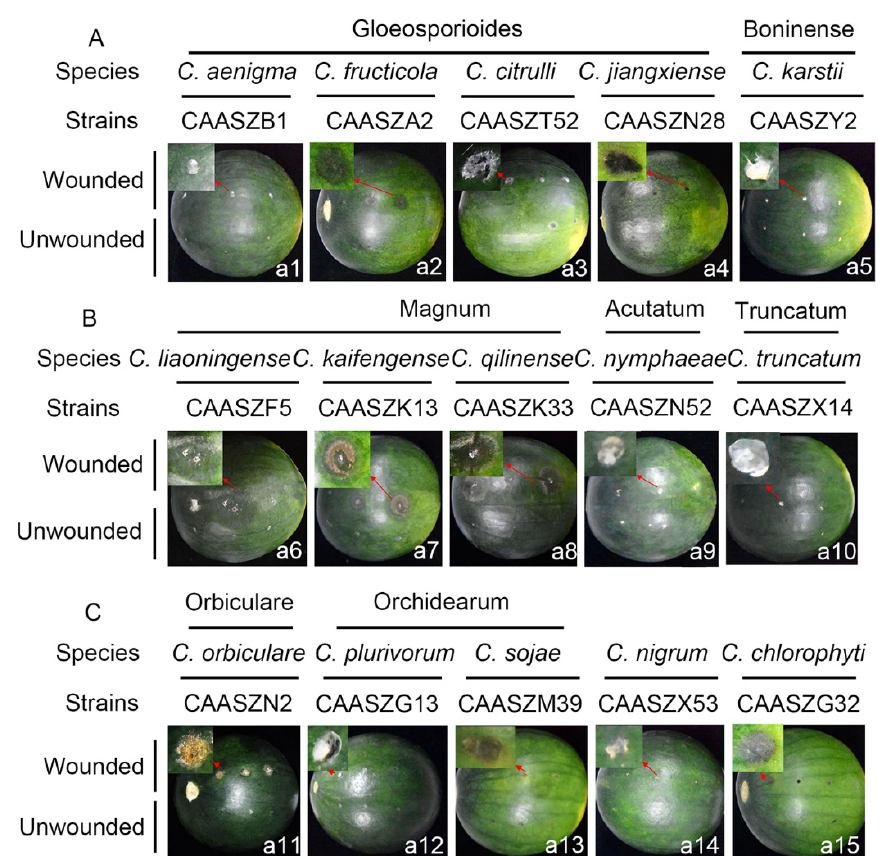
Figure 12. Symptoms of watermelon fruits ( Citrullus. lanatus cv. Motong) induced by inoculation of spore suspensions of 15 Colletotrichum spp. under unwounded and wounded conditions. The symptoms caused by these species were photographed at 6 dpi. ( a1 – a15 ) Under wounded and unwounded conditions, s symptoms induced by the isolates/species belonging to the C. gloeosporioides, C. boninense, C. magnum, C. acutatum, C. truncatum, C. orbiculare, and C. orchidearum complexe species